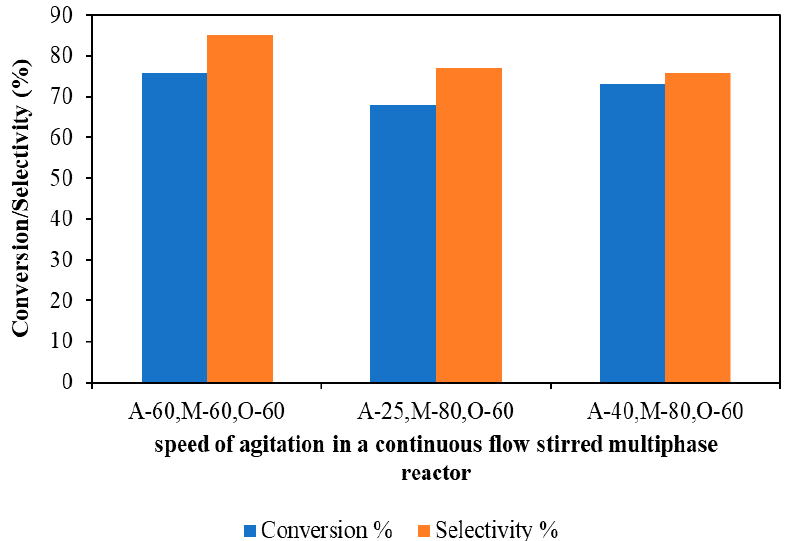
Figure 10. Effect of speed of agitation in a continuous flow stirred multiphase reactor. Epichlorohydrin 0.1 mol, n-decane 0.03 mol, toluene 150 cm 3 , guaiacol 0.1 mol, sodium hydroxide 0.2 mol, sodium chloride 0.6 mol, tetra-n-butylammonium bromide 0.14 mol, and water 150 cm 3 .